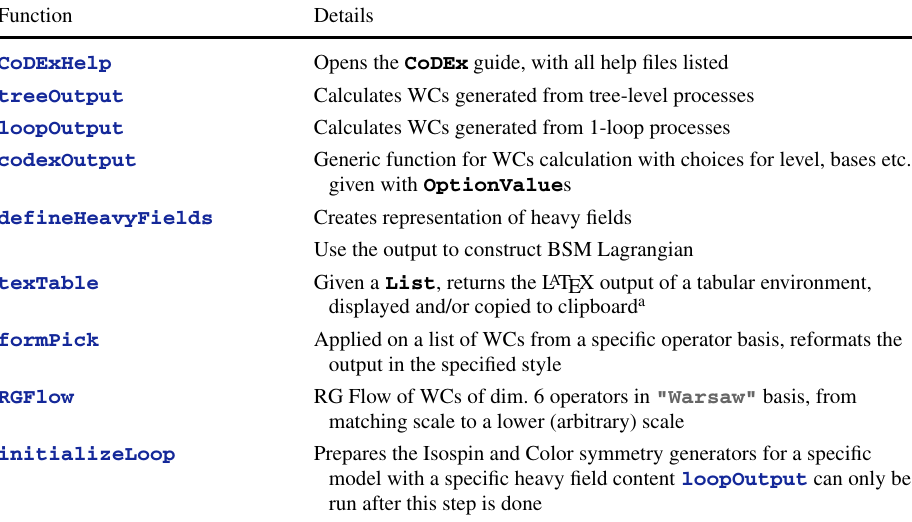
Table 2 Main functions provided by CoDEx